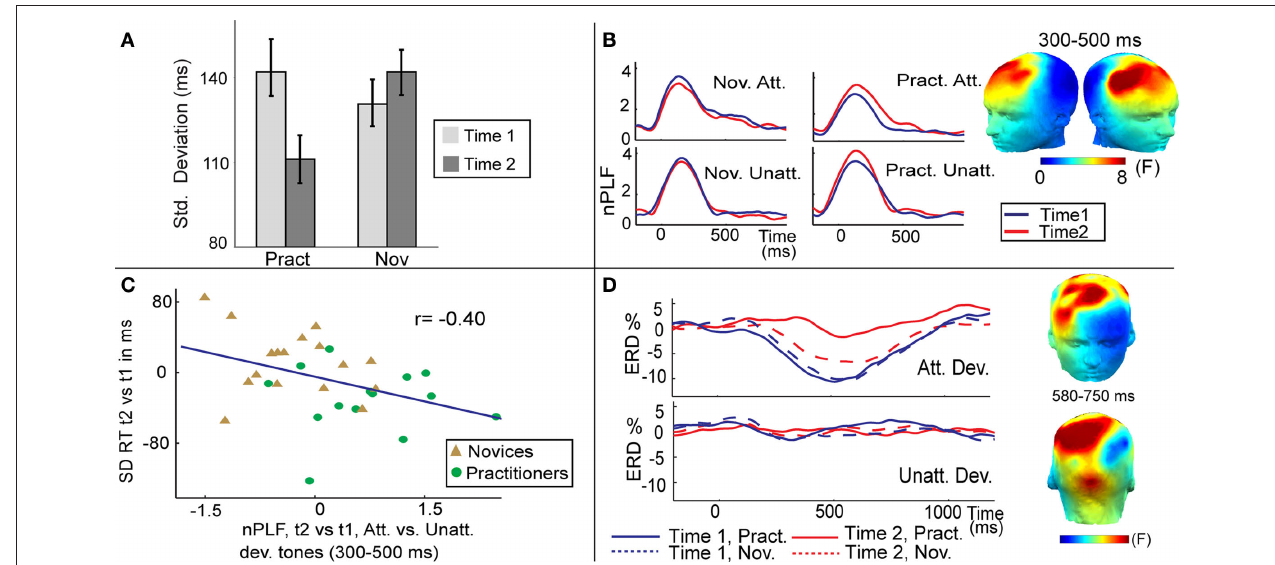
session, and attended (Att) and unattended (Unatt) deviant tones. Note that the observed increase in phase consistency to attended deviant tones over time was only observed for the practitioner group. (C) The correlation plot shows that the observed change in the trial-to-trial variability of brain responses predicted the observed behavioral change in the trial-to-trial variability of the RT. (D) Mental training selectively reduced cognitive effort as indexed by ERD. Time course of the ERD for attended and unattended deviant tones (Dev.) shown for the practitioners and novices separately. The scalp maps show the spatial distribution of the mental training-related decrease in beta-band (13–30 Hz) ERD to attended vs. unattended deviant tones [three-way interaction between group, session, and condition]. F values are averaged between 580 and 750 ms. Figure is adopted from Lutz et al.